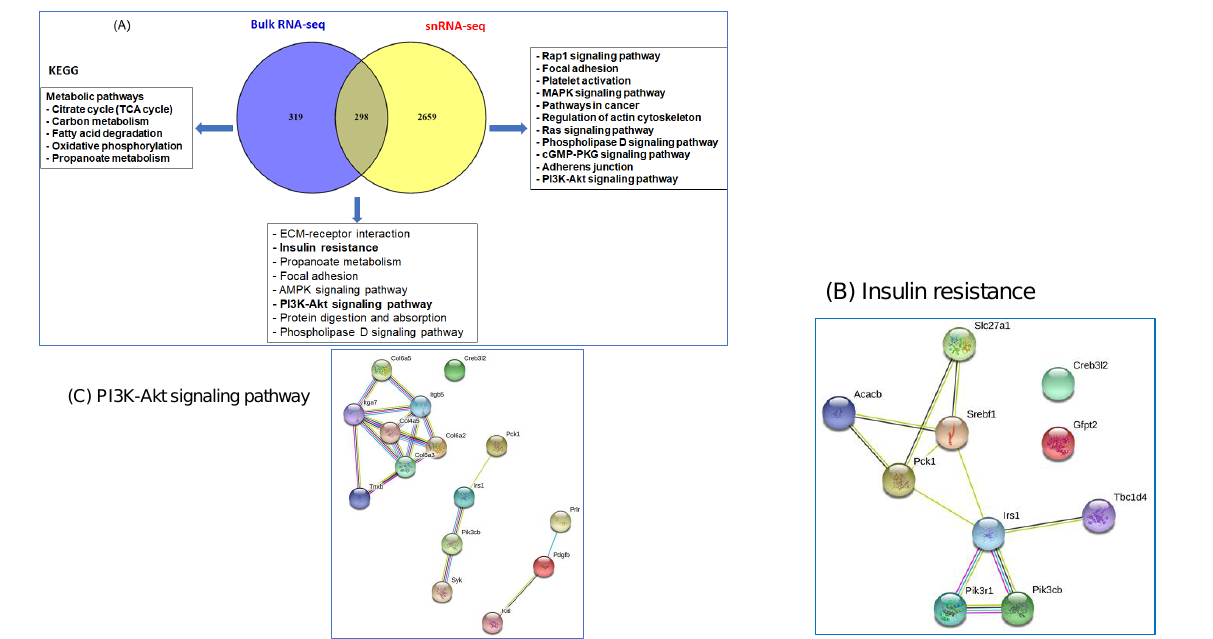
Figure 7. Comparison of the DEGs in bulk RNA-seq and snRNA-seq. ( A ) Venn diagram shows the comparison and overlap between the two transcriptomic analysis paradigms. The KEGG for 319 genes in bulk RNA-seq, 2659 genes in snRNA-seq and the overlap between the two systems 298 genes. ( B ) Gene networks for insulin resistance pathway. ( C ) Gene networks for PI3K-Akt signaling pathway. The gene − gene network analysis revealed that the DEGs are involved in various KEGG functional pathways, such as the AMPK signaling pathway, PPAR signaling pathway, and insulin resistance pathway.